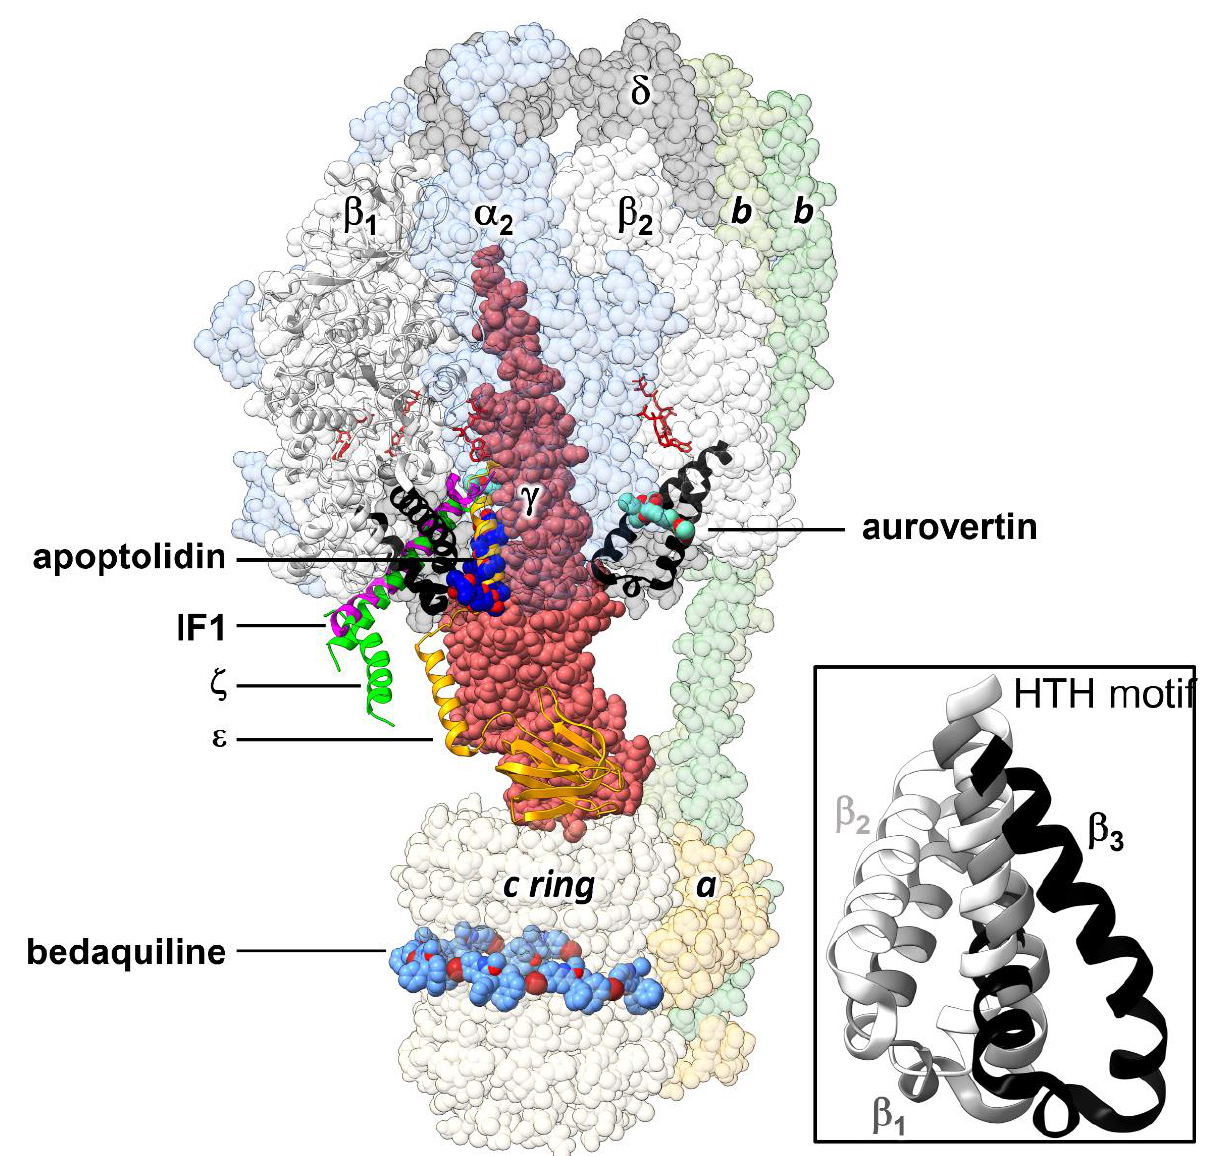
Figure 1. Schematic representation of the 3D structure of E. coli F O F 1 -ATP synthase, showing the binding sites of allosteric inhibitors that interact with the C-terminal domain of the β subunit. Inhibitors whose 3D structure in complex with the enzyme has been experimentally solved were docked by alignment on the cryoEM structure of the E. coli enzyme in an inhibited conformation by the ε subunit (PDB ID 6oqr [16]). HTH motifs of β 1 and β 2 are in black ribbons. The F 1 and F O subcomplexes are composed of the α 3 β 3 γδε and ab 2 c 10 subunits, respectively. The endogenous inhibitory ε (PDB ID 6oqr [16]), ζ (PDB ID 5dn6 [23]) and IF1 (PDB ID 1ohh [24]) subunits are shown in ribbons. The exogenous inhibitors aurovertin B (PDB ID 1cow [25]) and the glycomacrolide apoptolidin A (PDB ID 7md3 [26]) are shown in spheres. Here, also shown is the position of the anti-tuberculosis drug bedaquiline (PDB ID 7jg8 [27]), which occupies sites equivalent to those of oligomycin in the c ring. Nucleotides are shown in sticks. Inset: Alignment of the HTH motifs of the three β subunits observed in the self-inhibited structure of EcF 1 [16,22]. In this conformation, the ε subunit hampers the closing of one β subunit, adopting a half-closed conformation ( β 1 ). A β 1 -like conformation is also observed in the complexes with the glycomacrolides apoptolidin A and ammocidin A